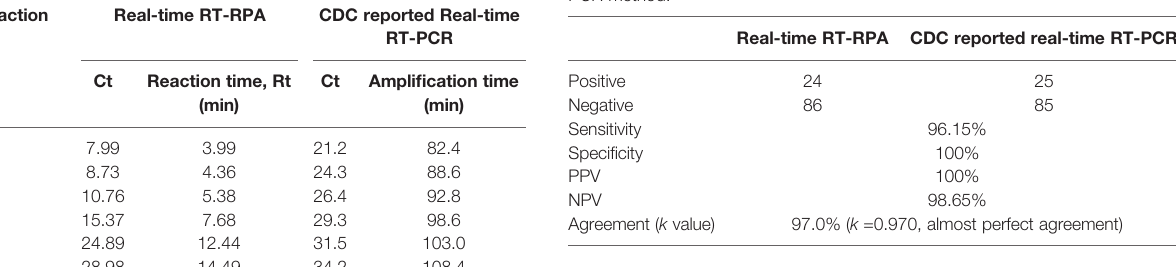
TABLE 5 | Diagnostic performance comparison between real-time reverse transcription isothermal recombinase polymerase ampli fi cation (RT-RPA) assay for human clinical samples (n =110) and reference CDC reported real-time RT- PCR